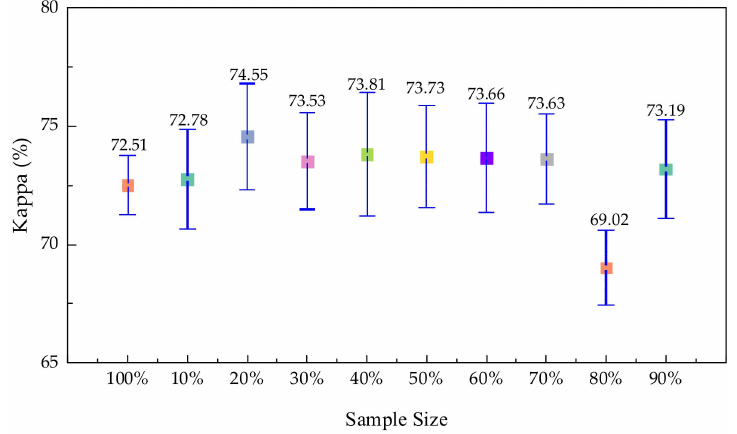
Figure 10. The Kappa and confidence intervals of SVM classifier after NKMNF with different proportion sample sizes (number of features = 45) in Indian Pines.